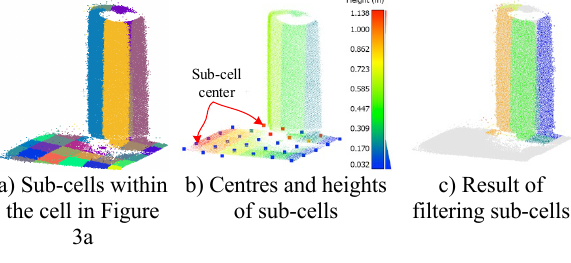
Figure 4 . Extract sub-cells representing vertical surfaces